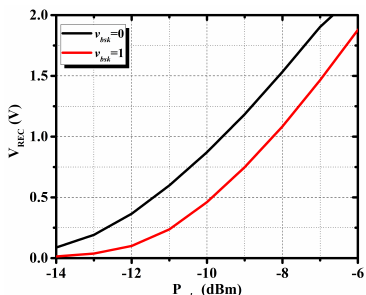
Figure 22. Post-layout simulation of the implemented ASK backscatter